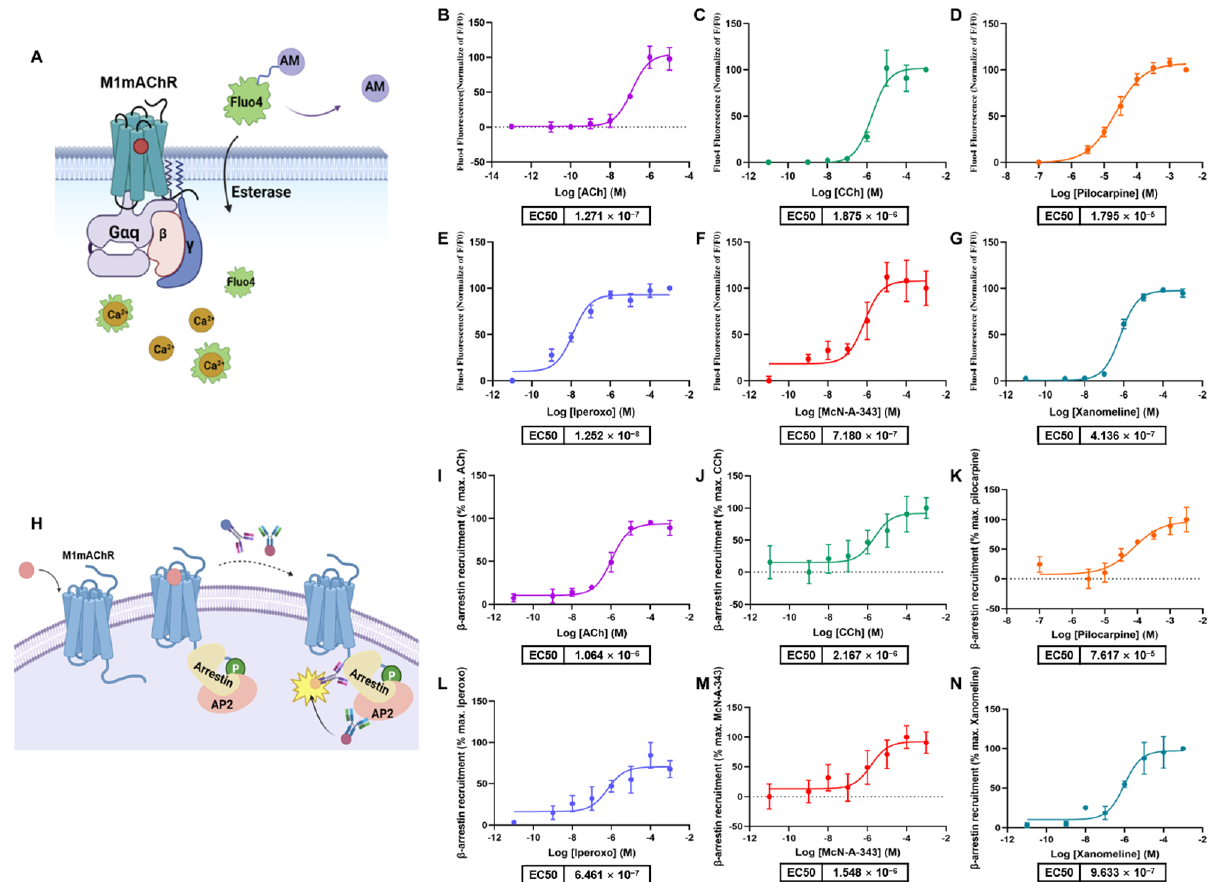
Figure 6. Determination of G α q and β -arrestin2 recruitment to M1mAChR using commercial meth- ods. ( A ) Schematic illustration of Fluo4-AM and dose-response curves for ( B ) ACh, ( C ) CCh, ( D ) Pilocarpine, ( E ) Iperoxo, ( F ) McN-A-343, and ( G ) Xanomeline, verified by Fluo4-AM. ( H ) Schematic illustration of FRET and dose-response curves for ( I ) Ach, ( J ) CCh, ( K ) Pilocarpine, ( L ) Iperoxo, ( M ) McN-A-343, and ( N ) Xanomeline, verified by FRET. Data are means ± S.E.M. of 3 independent ex- periments performed in duplicate.